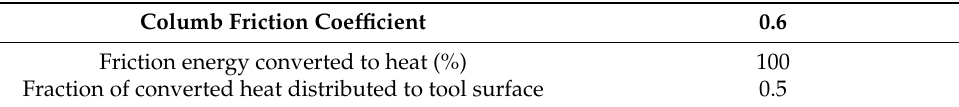
Table 4. Friction model parameters.